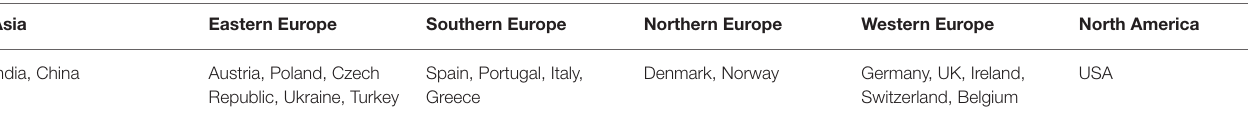
TABLE 1 | Pre-defined regions within the 79 NICUs in the SafeBoosC-III consortium. Asia Eastern Europe Southern